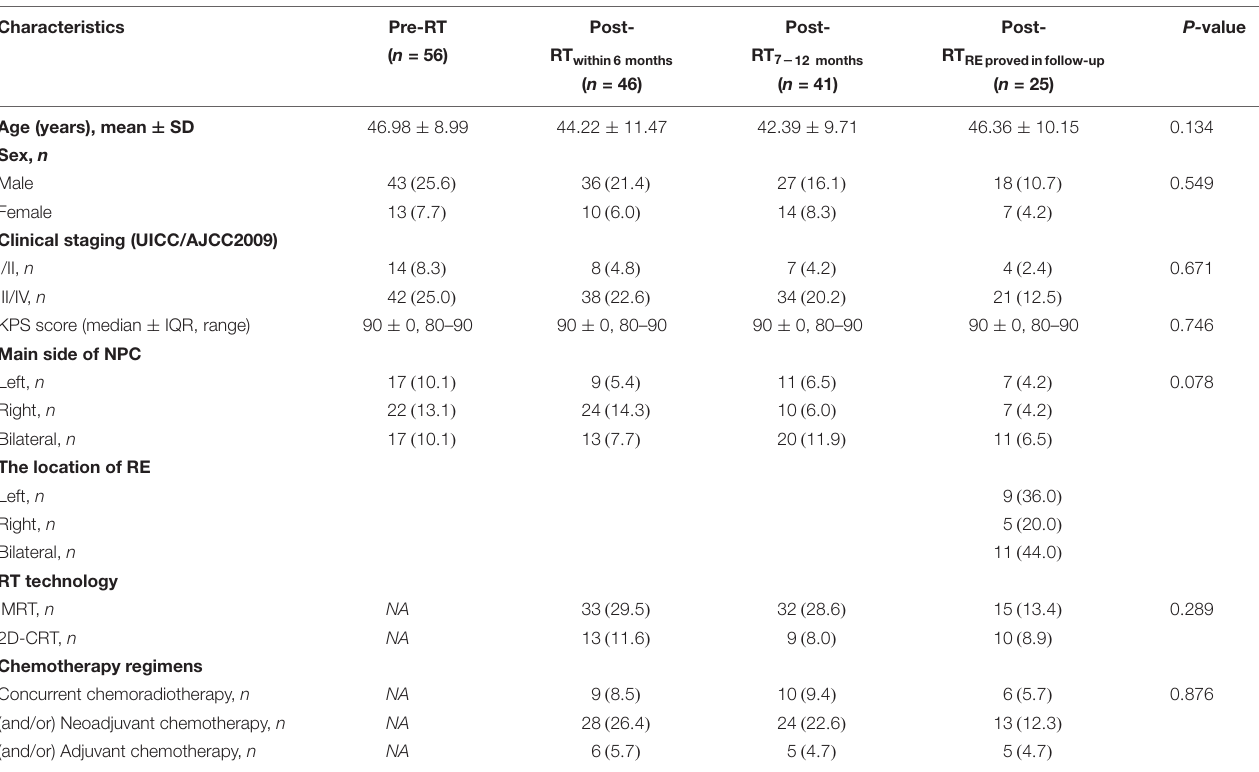
TABLE 1 | Clinical